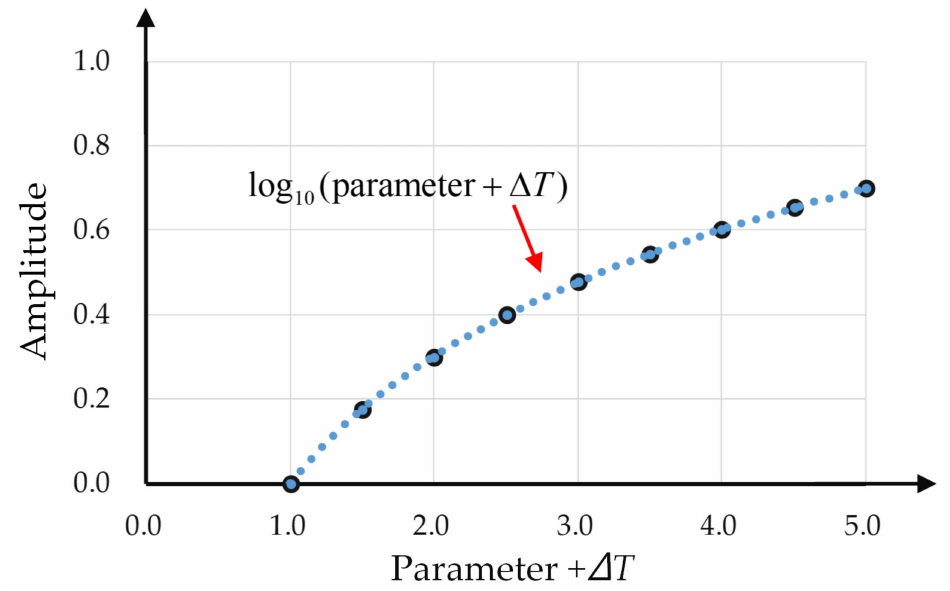
Figure 4. Log 10 curve depicting the relationship between the amplitude and parameter + operation time ∆ T